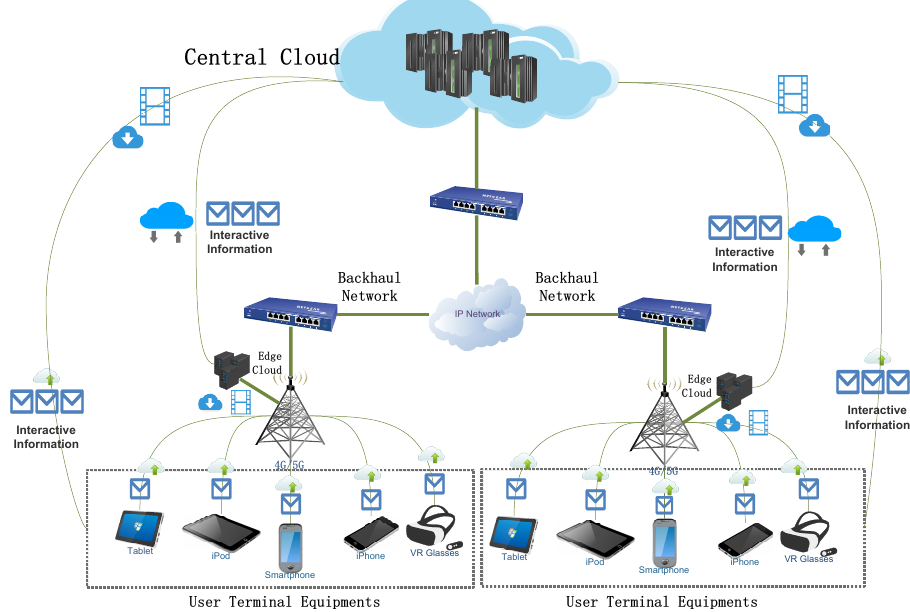
Figure 1. An overview of a mobile edge computing (MEC)